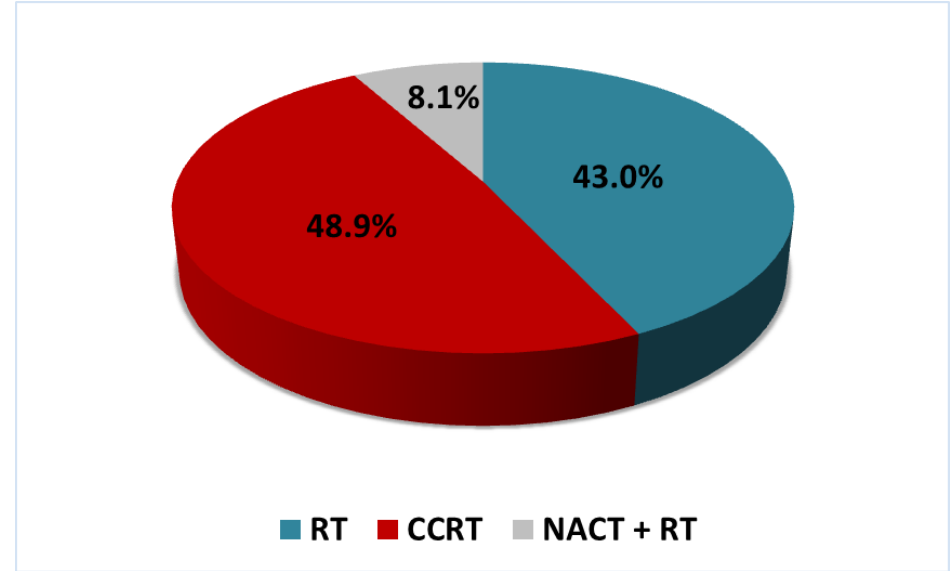
Figure 1. Distribution of 135 patients with cervical cancer (CC) by the treatment methods: radiation therapy (RT), concurrent chemoradiation therapy (CCRT) or neoadjuvant chemotherapy followed by radiotherapy (NACT + RT).